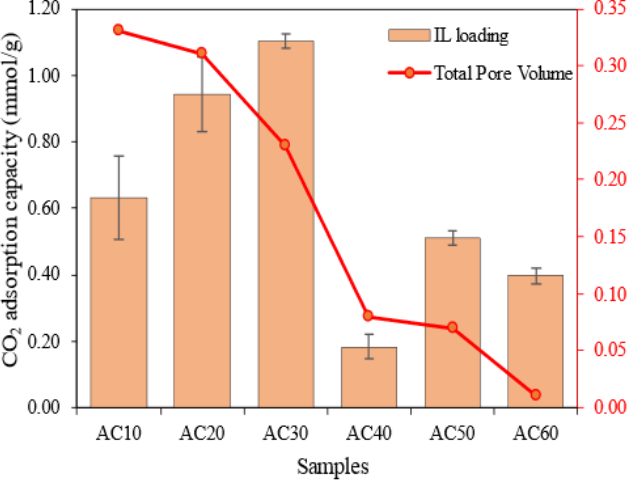
Figure 11. CO 2 adsorption capacity at 1 bar and 25 °C and total pore volume of AC functionalized with different amounts of IL.